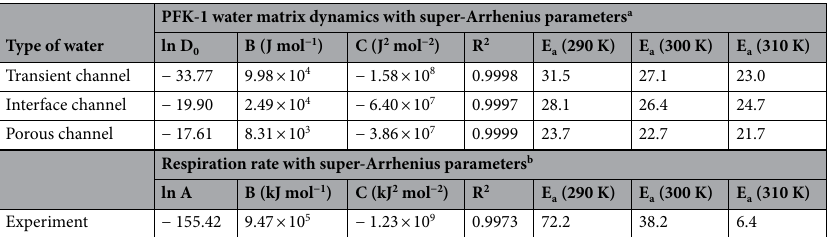
Table 1. Comparison of the derived super-Arrhenius parameters between PFK-1 water matrix dynamics and experimental respiration rates. a Values of the parameters according to ln D = ln D 0 + B / RT + C /( RT ) 2 , where R is 8.314 JK −1 mol −1 and the unit of B is J mol −1 and that of C is J 2 mol −2 by temperature evaluation at 260–340 K, where temperature-dependent E a values were estimated by Eq. (8) in units of kJ mol −1 . b Experimental data obtained from Ref. 8 , by refitting the measured data (see Fig. 1) to ln k = ln A + B / RT + C /( RT ) 2 , then deriving those parameters and temperature-dependent respiration